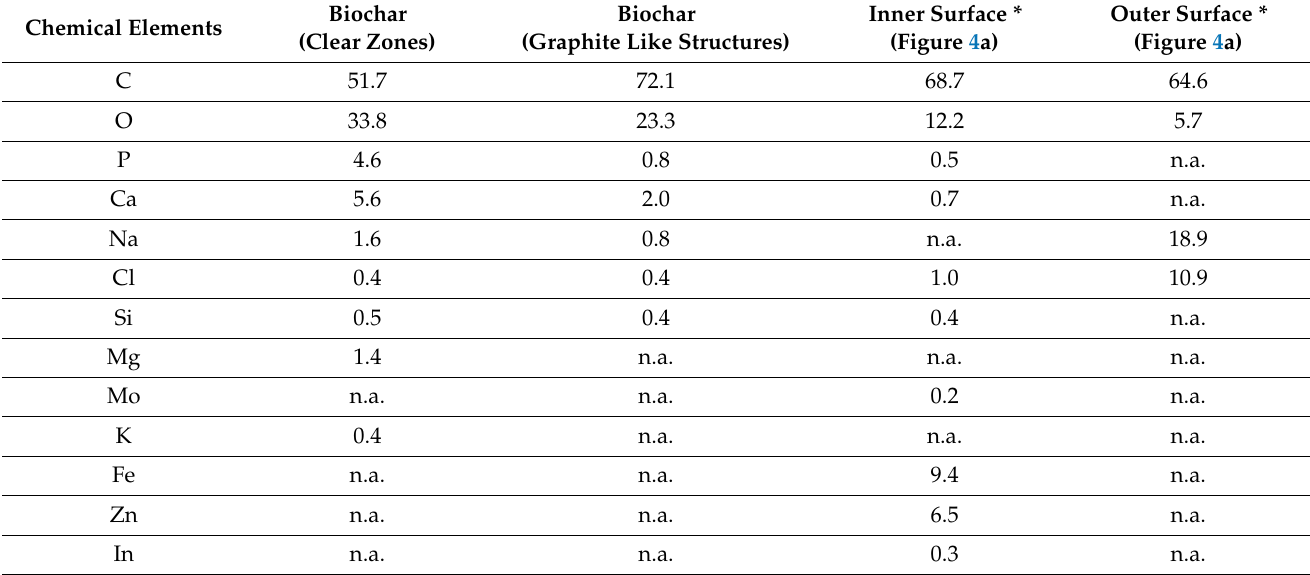
Table 1. Elemental composition of biochar and biochar depositions. n.a.: not available * samples were analyzed after being used in MFCs.